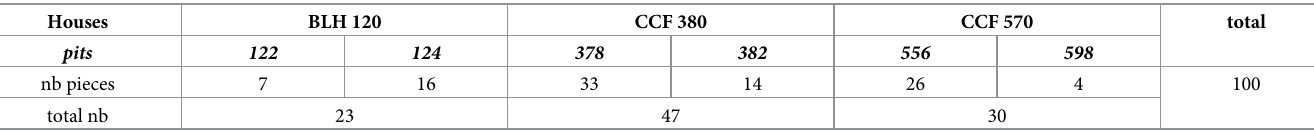
Table 1. Number of blades with butt